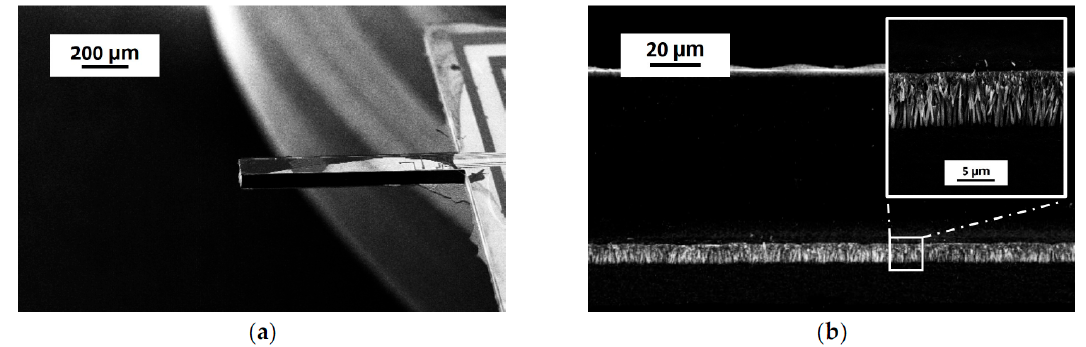
Figure 2. ( a ) Inclined-view SEM graph of Si microcantilever with its back surface coated with ZnO NRs; ( b ) and an enlarged detail in a cross-sectional view (inset shows ZnO NRs in a further enlarged view).